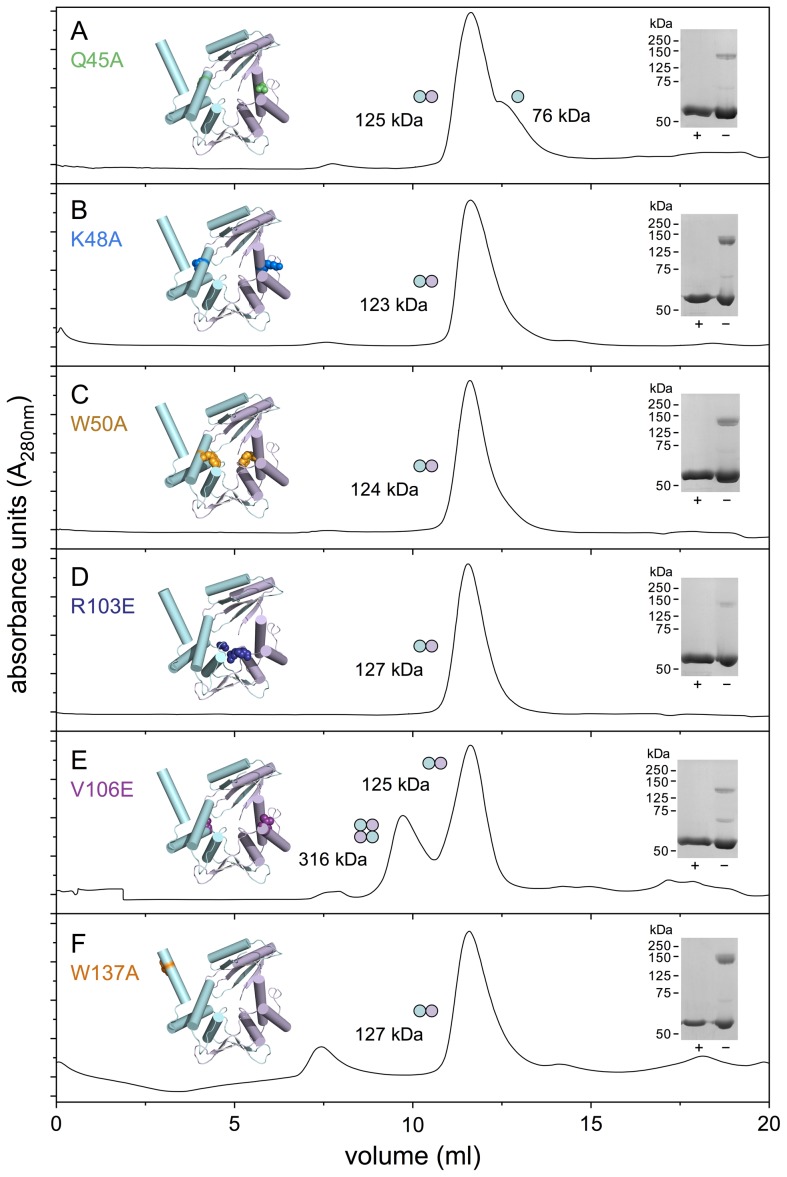
Size-exclusion chromatography of MBP-Orf mutant proteins.Proteins (1 mg/ml) were applied to a 24 ml Superose 12 HR 10/30 column. In each panel, the crystal structure of Orf protein shows the location of the relevant substitution mutant. Chain A is colored cyan and Chain B, lilac; the projecting C-terminal helix is absent from the latter. Predicted molecular weights for MBP-Orf are 59.6 kDa (monomer) and 119.2 kDa (dimer). Oligomeric states are depicted with a circle representing a single subunit and placed adjacent to the corresponding peak. Boiled (+) and unboiled (–) samples of each purified protein were separated on 12.5% SDS-PAGE and stained with Coomassie blue.